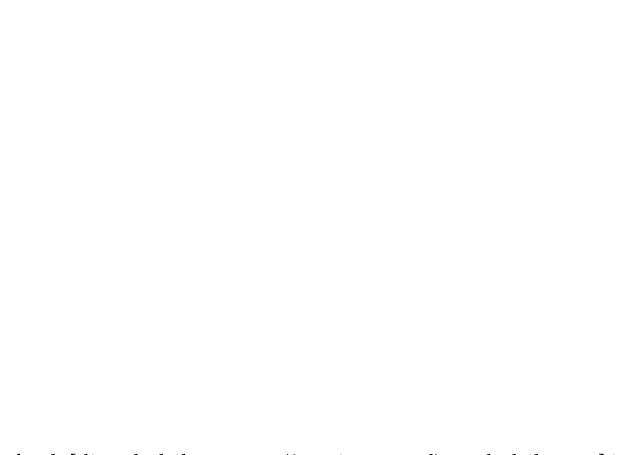
Table 1. Materials used in investigation.